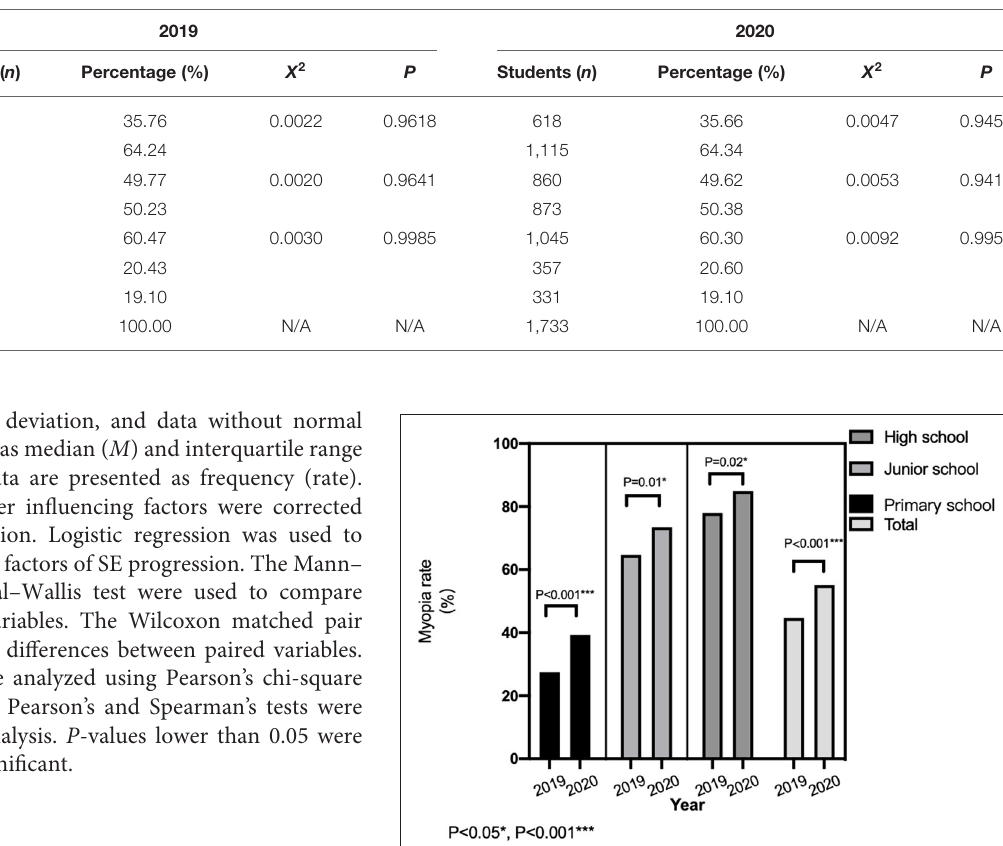
TABLE 1 | General information of the survey.